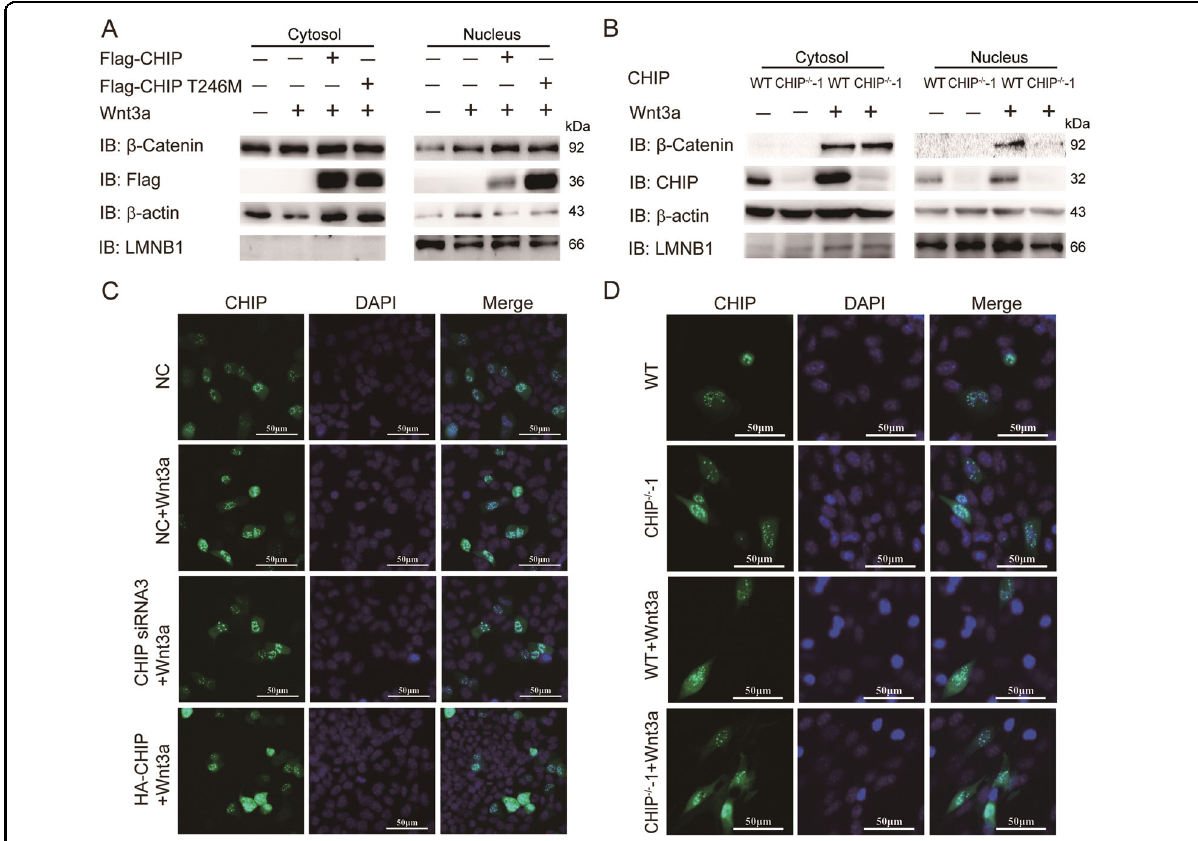
Fig. 2 CHIP accelerates the nucleus accumulation of β -catenin. A HEK293T cells were transfected with Flag-CHIP or Flag-CHIP T246M, and stimulated with Wnt3a (40 ng/ml) for 4 h. Western blot analyzed the endogenous β -catenin from cytosolic and nuclear fractions. B Western blot analysis of endogenous β -catenin from the cytoplasm and nuclear fractions of WT or CHIP − / − HT22 cells. C – D Fluorescence analysis was performed to detect the distribution of β -catenin. HEK293T cells were transfected with control siRNA (NC), CHIP-speci fi c siRNA 3 (40 nM), or HA-CHIP along with β -catenin-GFP, and then stimulated with Wnt3a (40 ng/ml) for 4 h ( C ). WT and CHIP − / − HT22 cells were transfected with β -catenin-GFP, and stimulated with Wnt3a ( D ). Fluorescence analysis of β -catenin nuclear localization with GFP (green), DNA was visualized with DAPI (blue). All results were representative of three independent